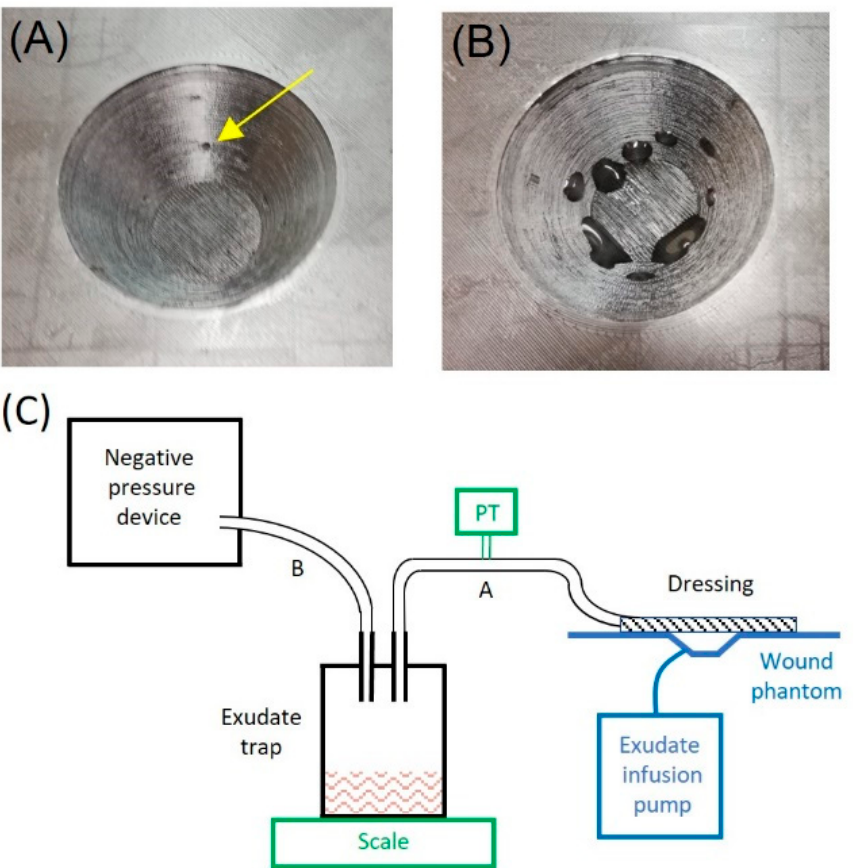
Figure 2. Detailed picture of the 3D printed wound phantom: ( A ) shows the orifices for exudate secretion (one of them noted by a yellow arrow); ( B ) shows exudate secretion by means of an infusion pump. ( C ) Bench test diagram. The functional setting (in black) consists of the negative pressure device connected to the wound phantom (in blue) through a liquid bottle trap for the exudate by flexible tubes A and B and a conventional wound dressing. Two added measuring devices (in green) were added only for bench testing: the exudate trap bottle was placed on a scale to measure the exudate suctioned, and a negative pressure transducer (PT) was connected to tube A to measure actual pressure at the wound.